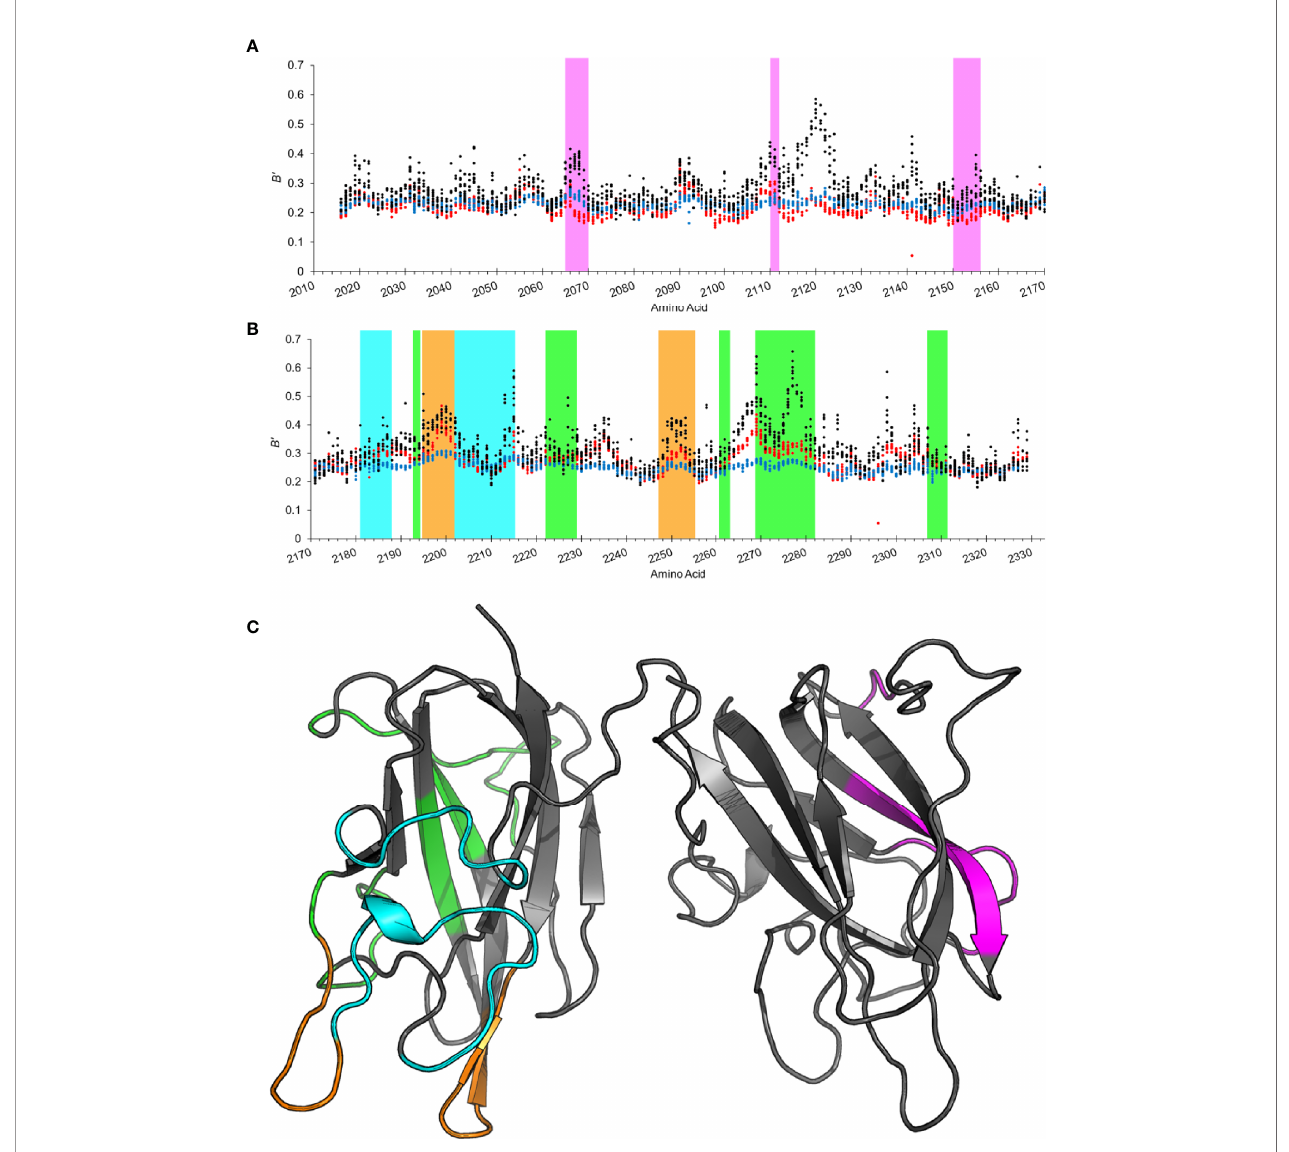
FIGURE 3 | Anti-C domain inhibitors reduce atomic B-factors on solvent-exposed loops. (A, B) Normalized atomic B-factors averaged for each epitope in the (A) C1 domain and (B) C2 domain from free ET3i (black, PDB ID: 6MF0), ET3i:G99 (blue, PDB ID: 7KBT), and ET3i:2A9 (red, PDB ID: 7K66). (C) Cartoon representation of the C1 and C2 domains from the free ET3i crystal structure (PDB ID: 6MF0, model A). Antibody epitopes are highlighted (2A9, magenta; G99, green; 3E6, cyan; BO2C11,